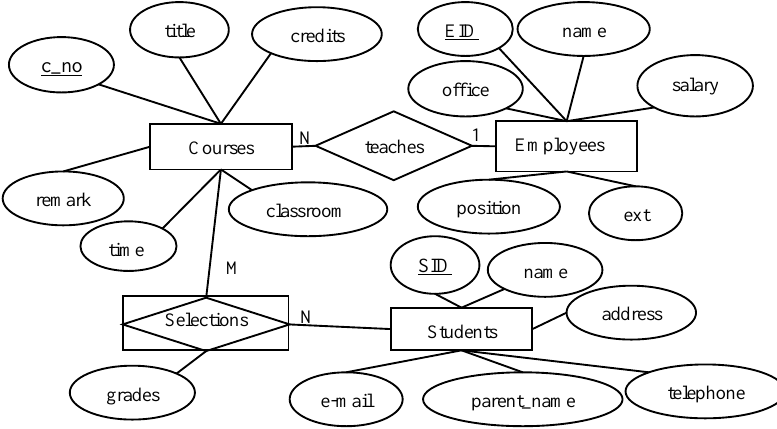
Figure 1. An entity-relationship diagram ( ERD) example.